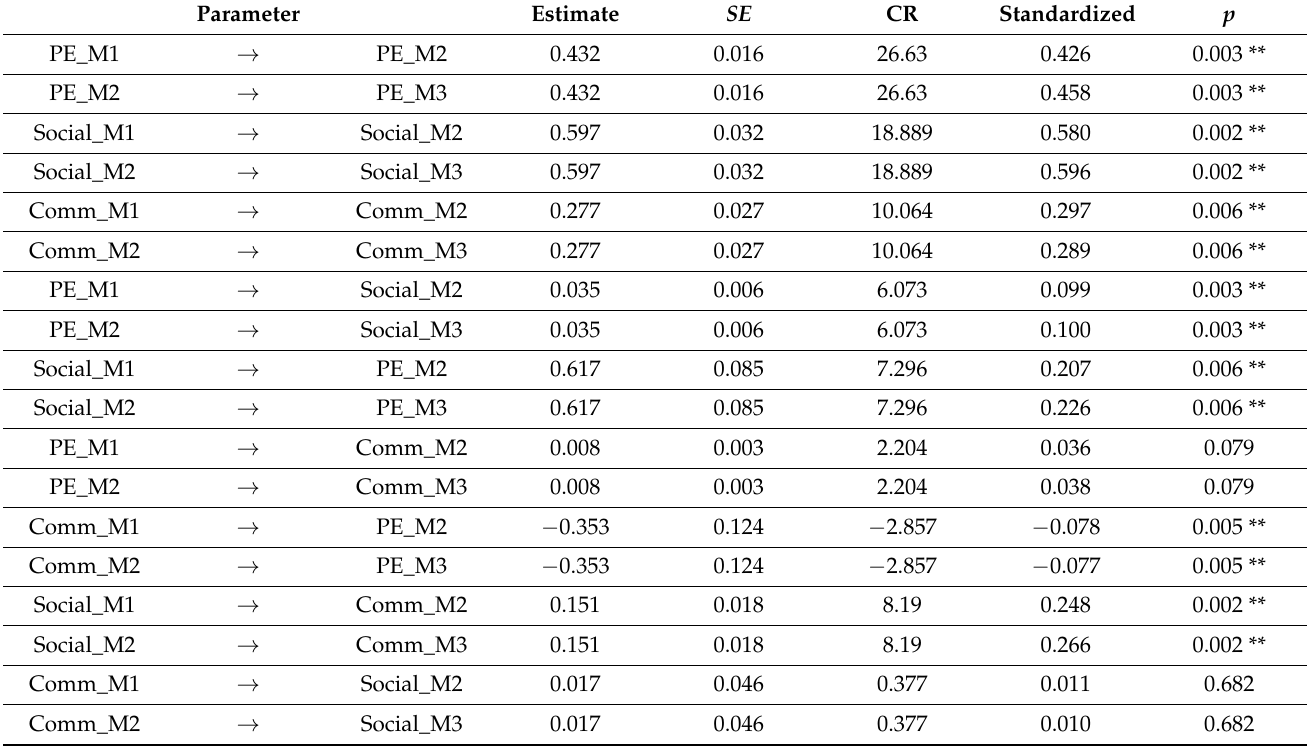
Table 4. Structural regression analysis results for the final